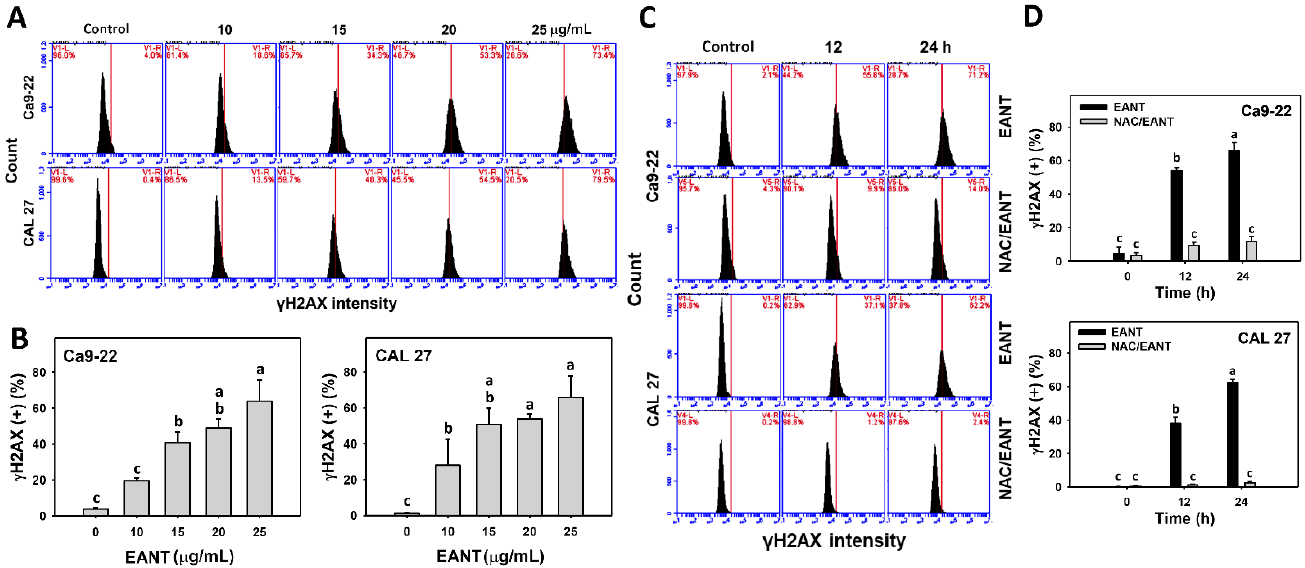
Figure 9. γ H2AX analysis. ( A , B ) γ H2AX pattern and statistical analysis for EANT treated oral cancer cells (CAL 27 and Ca9-22) for 24 h. ( C , D ) NAC (2 mM) pretreatment outcome on γH2AX patterns and statistical analysis in EANT treatments (0 and 25 μg/mL) for 12 and 24 h. Data (means ± SD, n = 3) showing non-overlapping alphabets differ significantly for multiple comparisons ( p < 0.05).